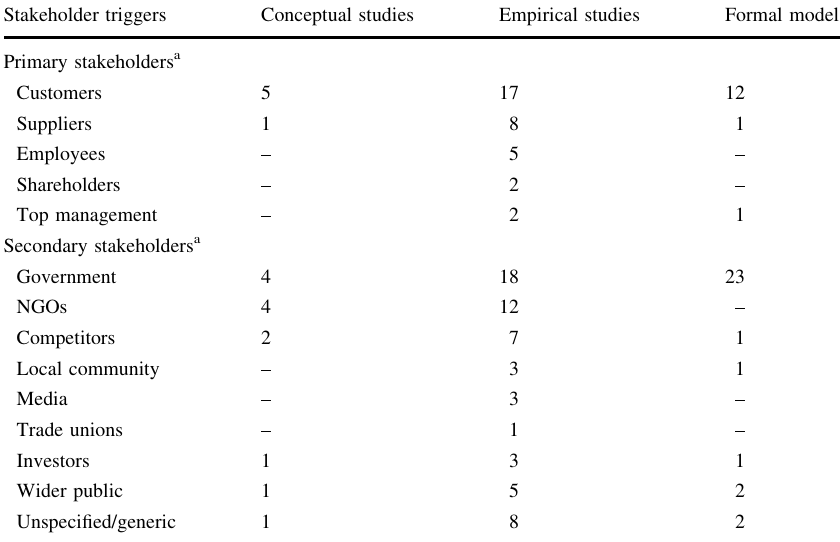
Table 13 Detailed distinction between primary and secondary stakeholder triggers for SSCM Stakeholder